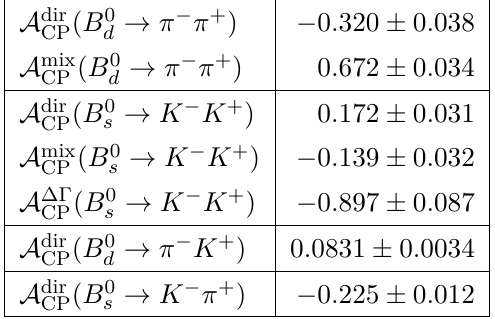
Table 2 . Combined Run I [26] and Run II LHCb results for the CP asymmetries of B modes taken from